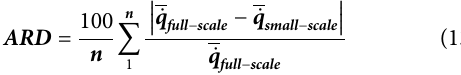
( Figure 9 ) between the APHE and its small-scale representative